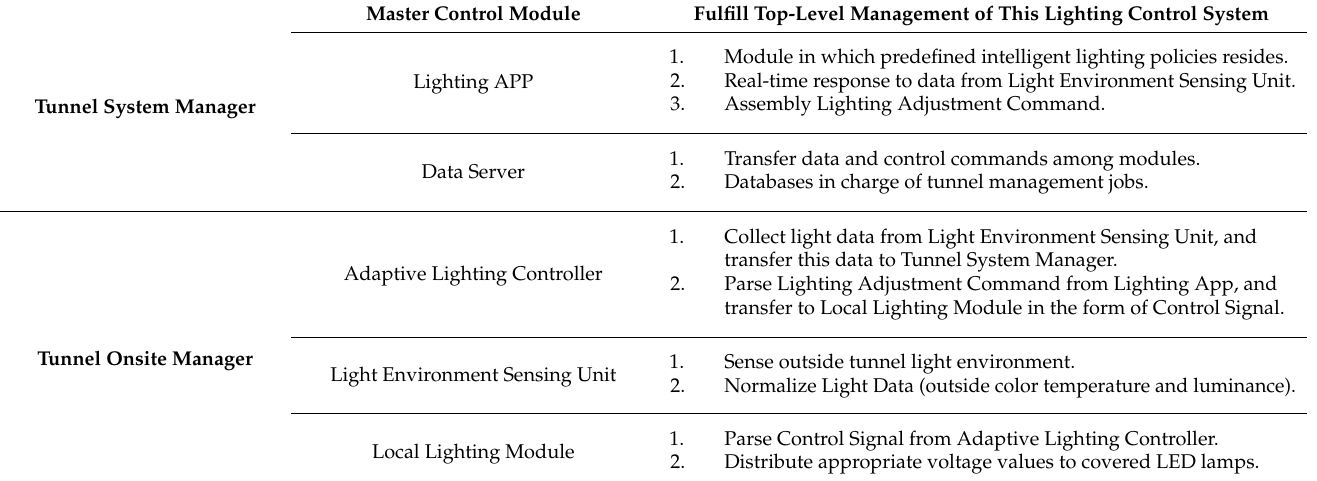
Table 4. Functions and components of the lighting control system.